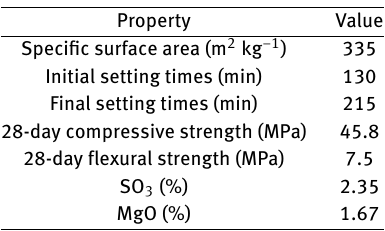
Table 1: Cement properties